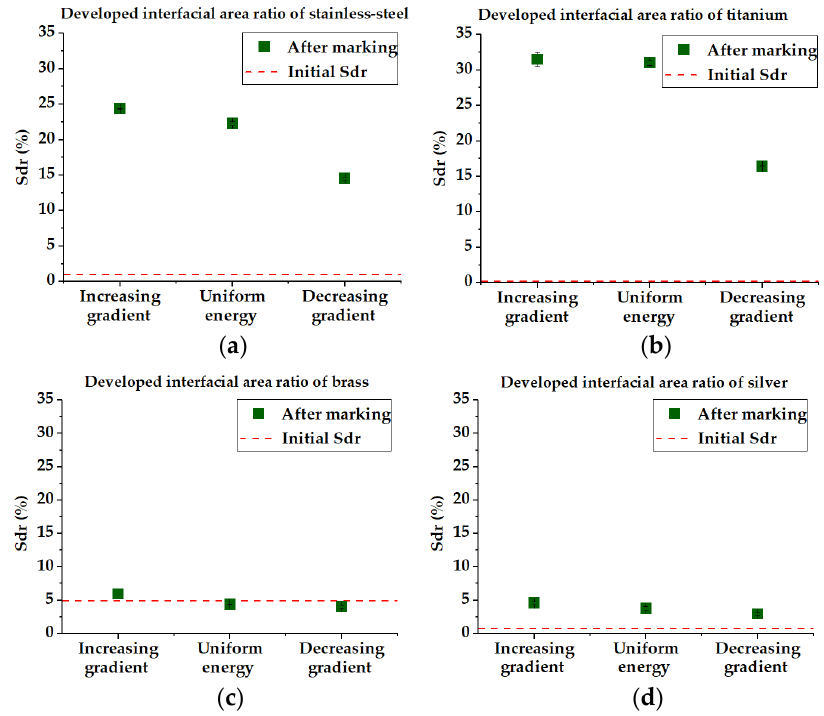
Figure 6. S dr parameters of ( a ) stainless steel, ( b ) titanium, ( c ) brass and ( d ) silver. The trend is quite similar to the roughness parameter R a .